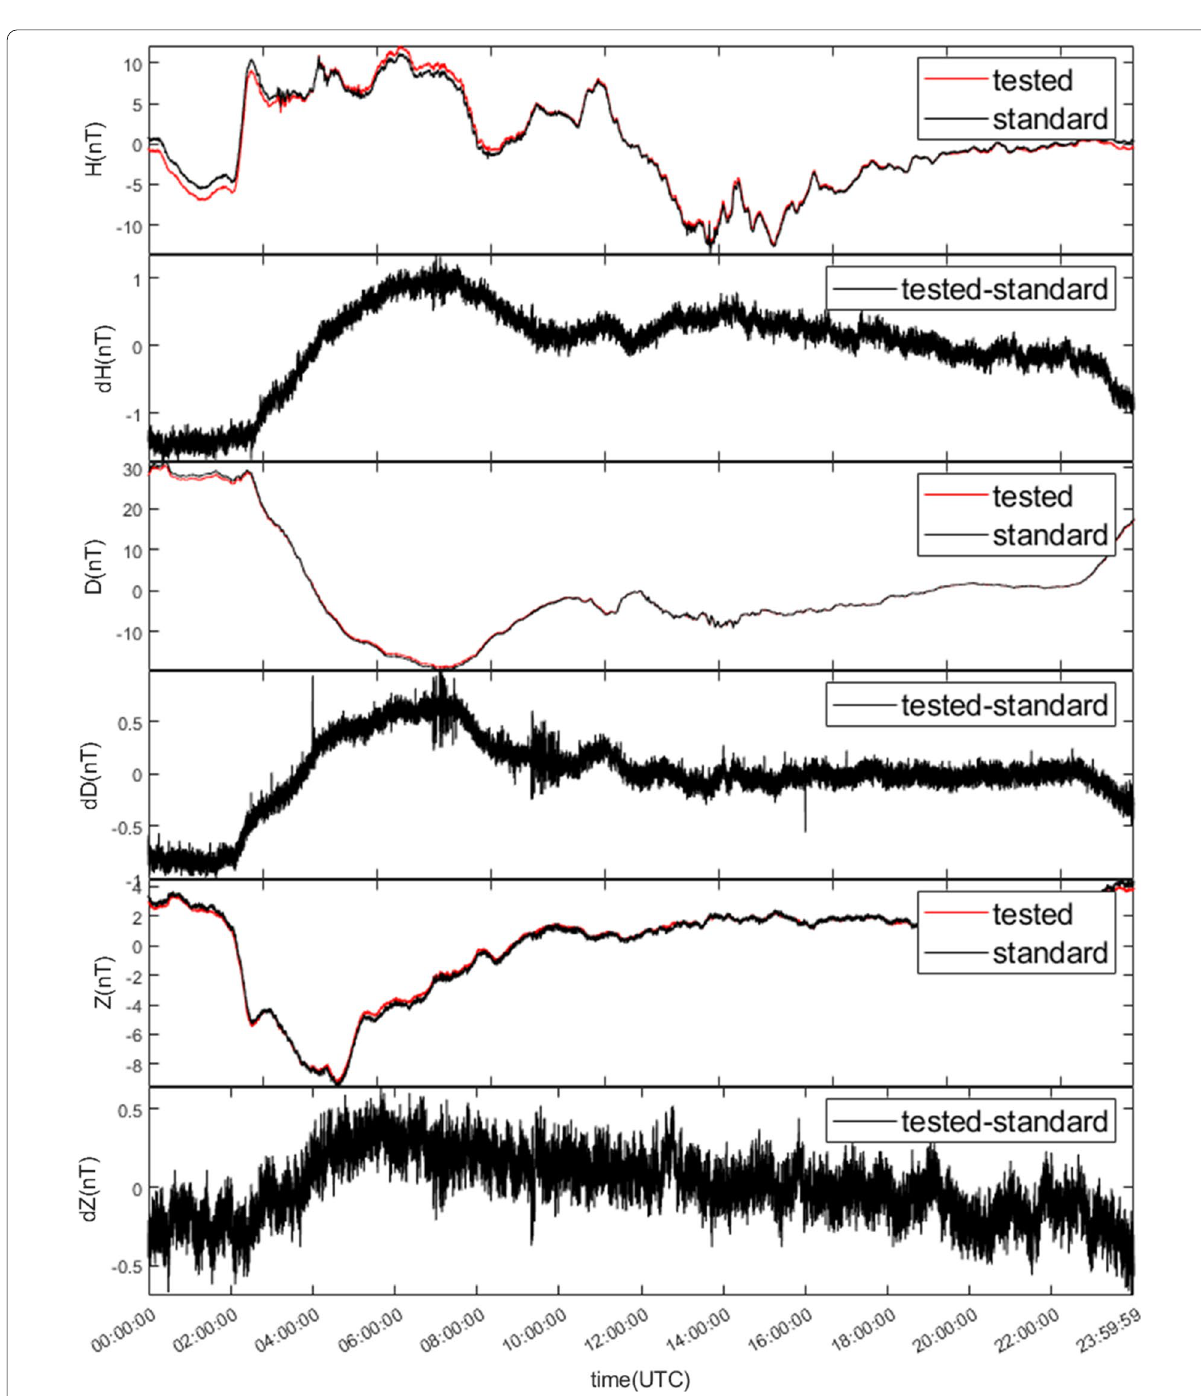
Fig. 1 Influence characteristics of the attitude angle and scale factor in the morphology of comparative geomagnetic observations. The figure shows the daily geomagnetic variation and vector difference on June 17, 2020, at the Yunlong (YUL) observatory. Because of the heading angle deviation, the difference, dH, has a similar morphological change to the D component. Because of the scale factor, the dD and dZ differences are similar to the morphological variations of the D and Z components,